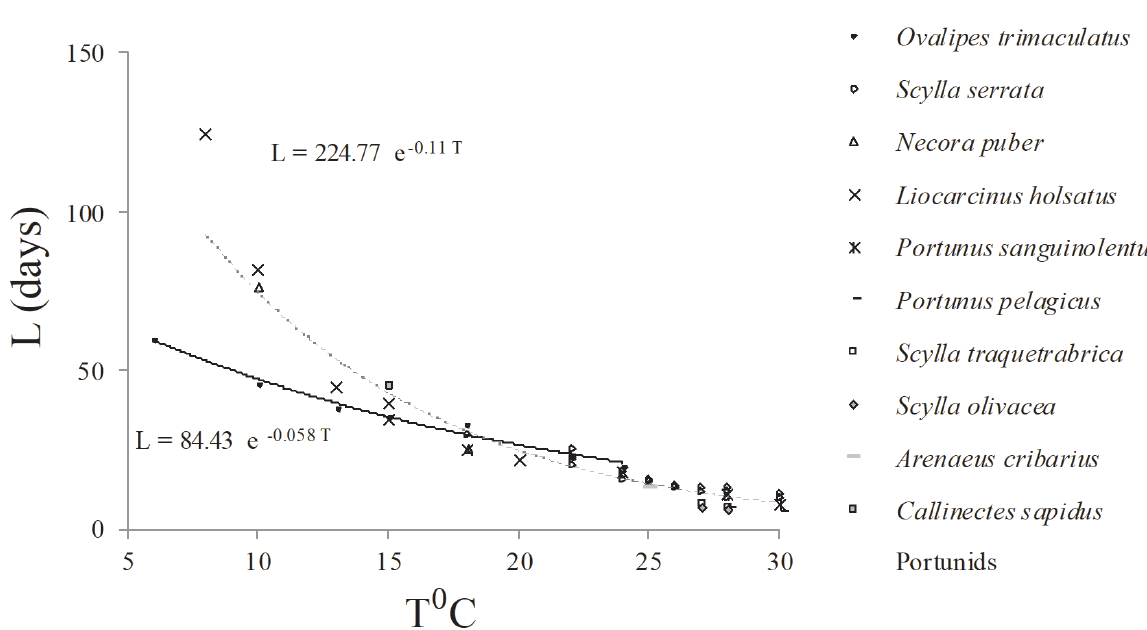
Figure 2. Length of embryogenesis of portunid crabs (L) at different seawater temperatures. The black solid line represents an exponential regression model fitted to data on the length of Ovalipes trimacul atus embryogenesis, and the grey dashed line represents an exponential regression model fitted to data on several other portunids pooled together (Choy 1991, Samuel & Soundarapandían 2009, Churchill 2003, Ates et al. 2012, Pinheiro & Franzoso 2002, Soundarapandían & Tamizhazhagan 2009, Amsler & George